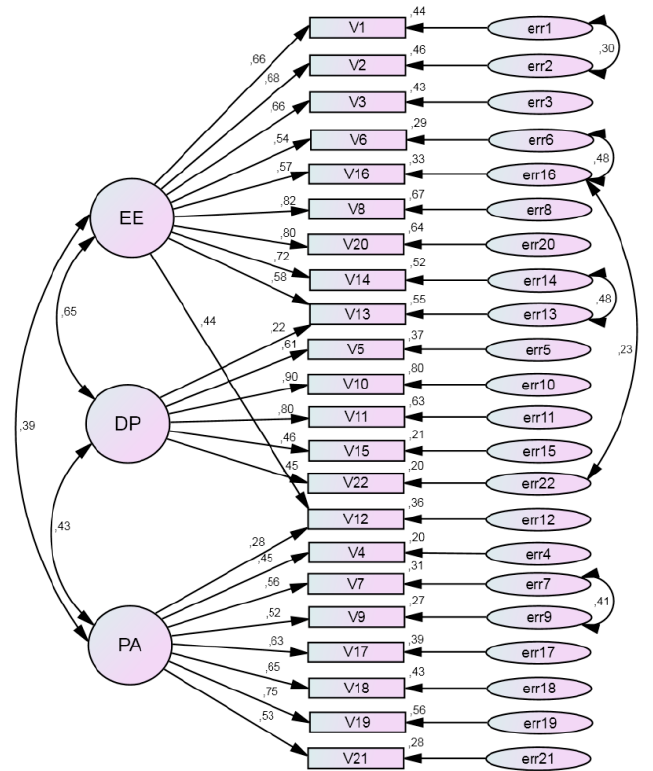
Figure 2. Path diagram with standardized estimates of the factorial structure for the final Maslach